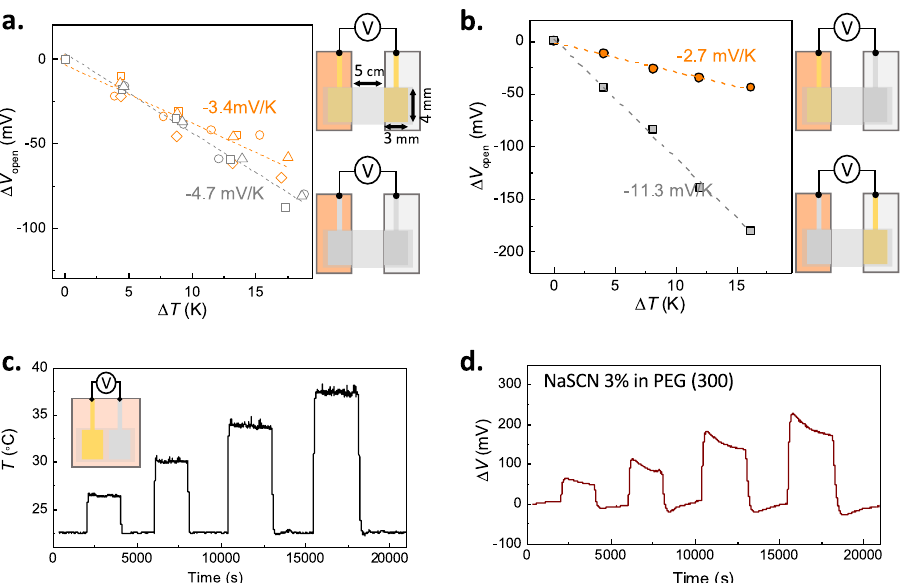
Fig. 2 Investigation of sensor mechanism by heating only one of the electrodes (heating is depicted by the orange shading). a Change in surface potential upon heating one of the electrodes for symmetric devices composed of two gold electrodes (yellow symbol shapes, results for four devices) or two aluminum electrodes (gray symbol shapes, results for three devices). b Same as in a but for an asymmetric device upon heating either the gold electrode (yellow) or the aluminum electrode (gray). c Controlled temperature changes applied to an EATS with a different electrolyte based on 3% NaSCN in PEG (inset). d Open-circuit potential variations of the same device upon the heat cycles presented in c . All measurements were performed in a cleanroom at RH =